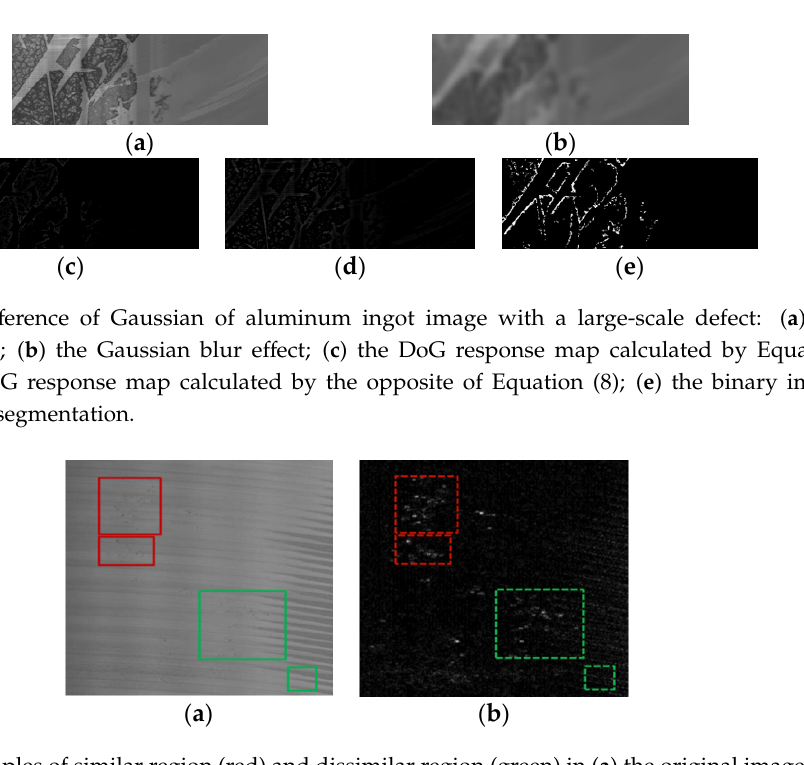
Figure 8. Examples of similar region (red) and dissimilar region (green) in ( a ) the original image and ( b ) the gradient image.